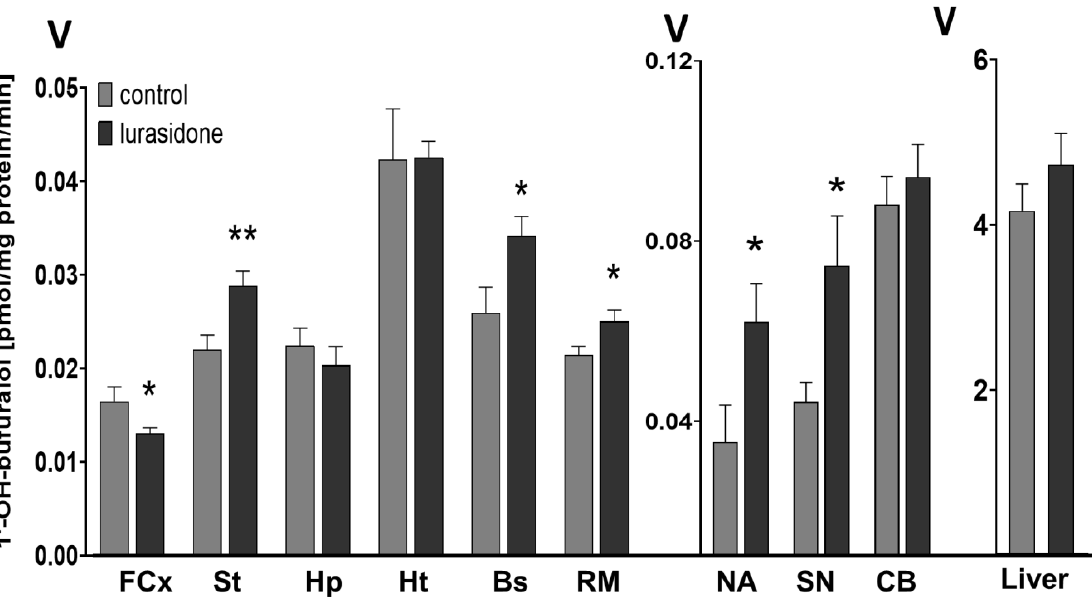
Figure 1. The influence of the two-week treatment with lurasidone on the CYP2D activity measured in microsomes derived from the selected brain structures or liver. The presented values are the means ± S.E.M. of 15 samples (from 15 animals) for the cerebellum, remainder of brain, and the liver; of 7 samples (each sample contained 2 pooled brain structures from 2 animals) for the frontal cortex; brain stem, striatum, and hippocampus; and of 5 samples (each sample contained 3 pooled brain